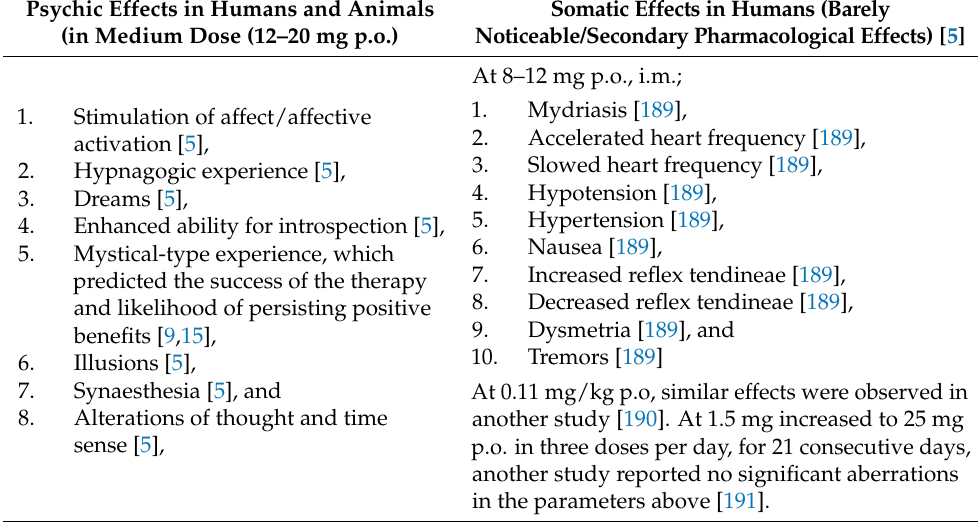
Table 3. Psychic vs. somatic effects of psilocybin.